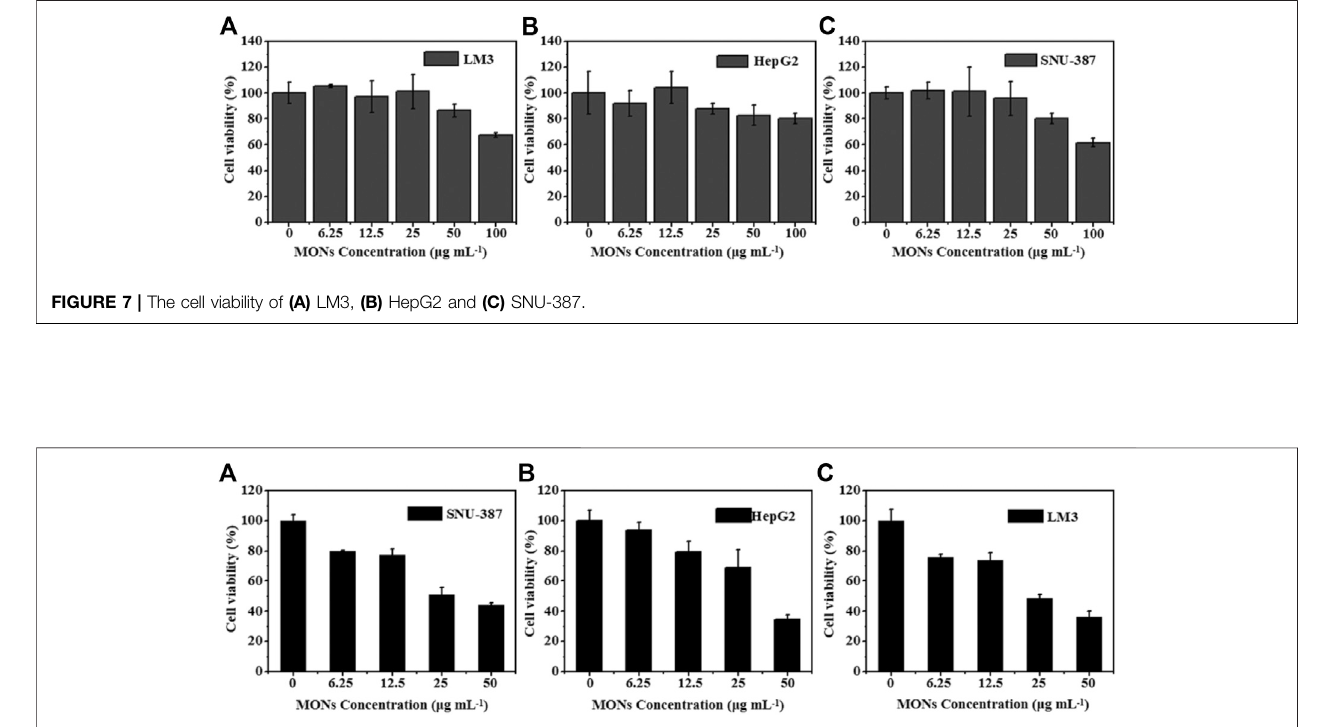
FIGURE 8 | The therapy effect in vitro . (A) SNU-387 (B) HepG2, and (C) LM3 were exposed to 808 nm irradiation for 10 min (1.3 W cm − 2